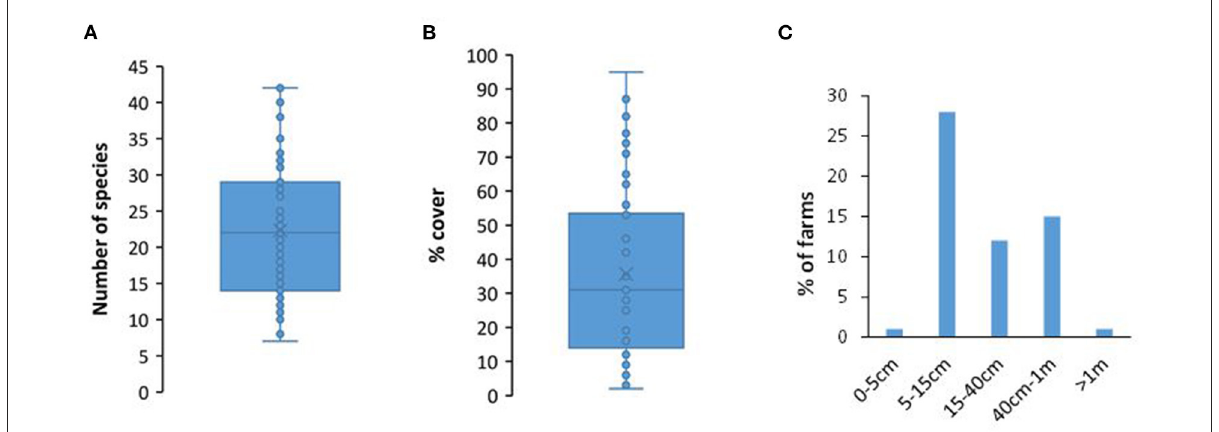
FIGURE4 Vegetation metrics for quadrats on PFLA farms: (A) box plot of total species richness across all farms showing mean, upper and lower quartiles and outliers, (B) box plot of % cover of forbs showing mean, upper and lower quartiles and outliers, and (C) bar chart of % farms with different vegetation height